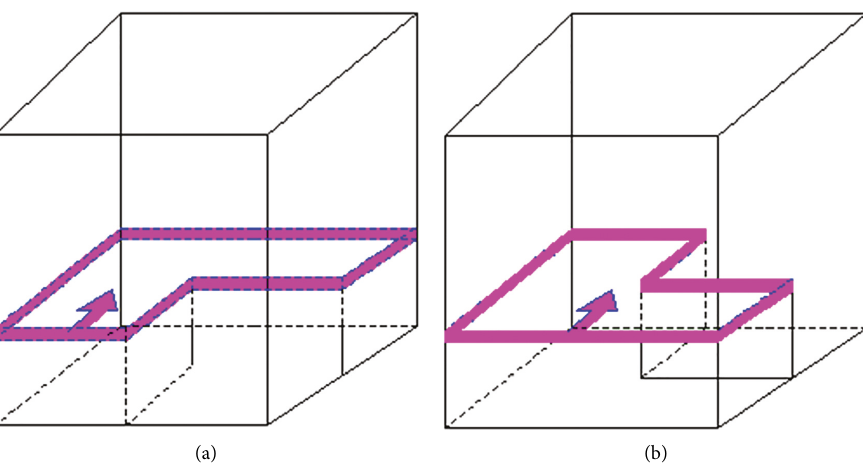
Figure 1: The three-dimensional mining model of working face with variable length. (a) Forward knife handle working face. (b) Reverse knife handle working face.